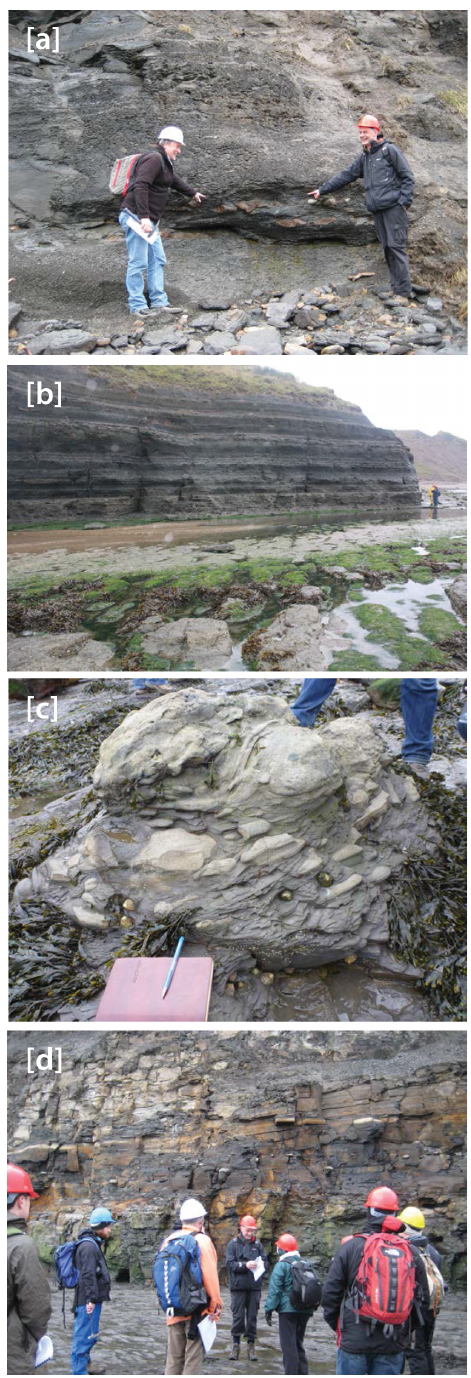
Figure 5. Highlights of the Cleveland Basin field excursion, York- shire. (a) GSSP for the base of the Pliensbachian Stage (Robin Hood’s Bay). (b) Potentially regularly cyclic late-Sinemurian suc- cession (Robin Hood’s Bay). (c) Probable methane seep carbonate mound and concretions in early Toarcian strata (Robin Hood’s Bay). (d) Exposure of the Jet Rock (record of the Toarcian OAE) at Port